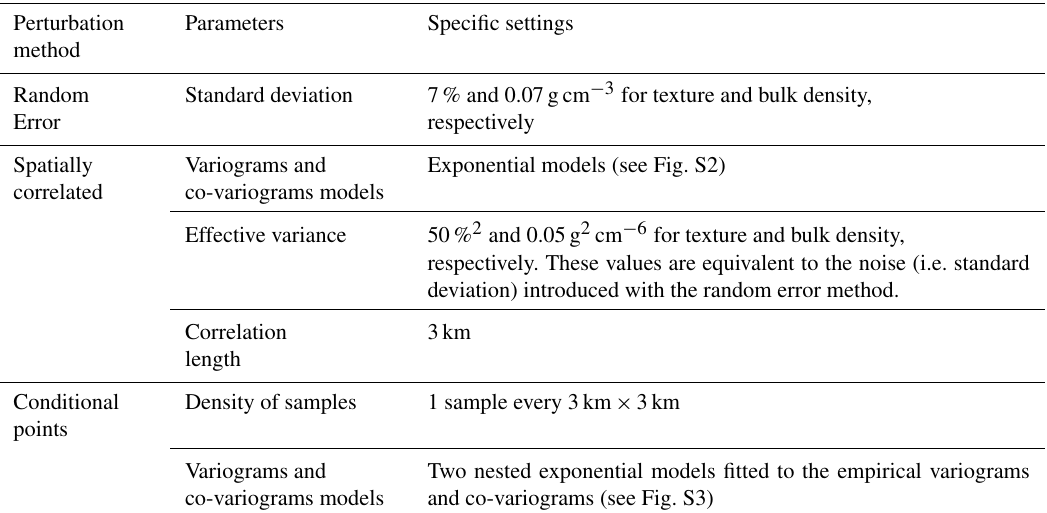
Table 1. Parameter settings for each perturbation method (random error, spatially correlated and conditional points). Variogram models used for the spatially correlated and conditional points methods are showed in the Supplement (Figs. S2 and S3, respectively).